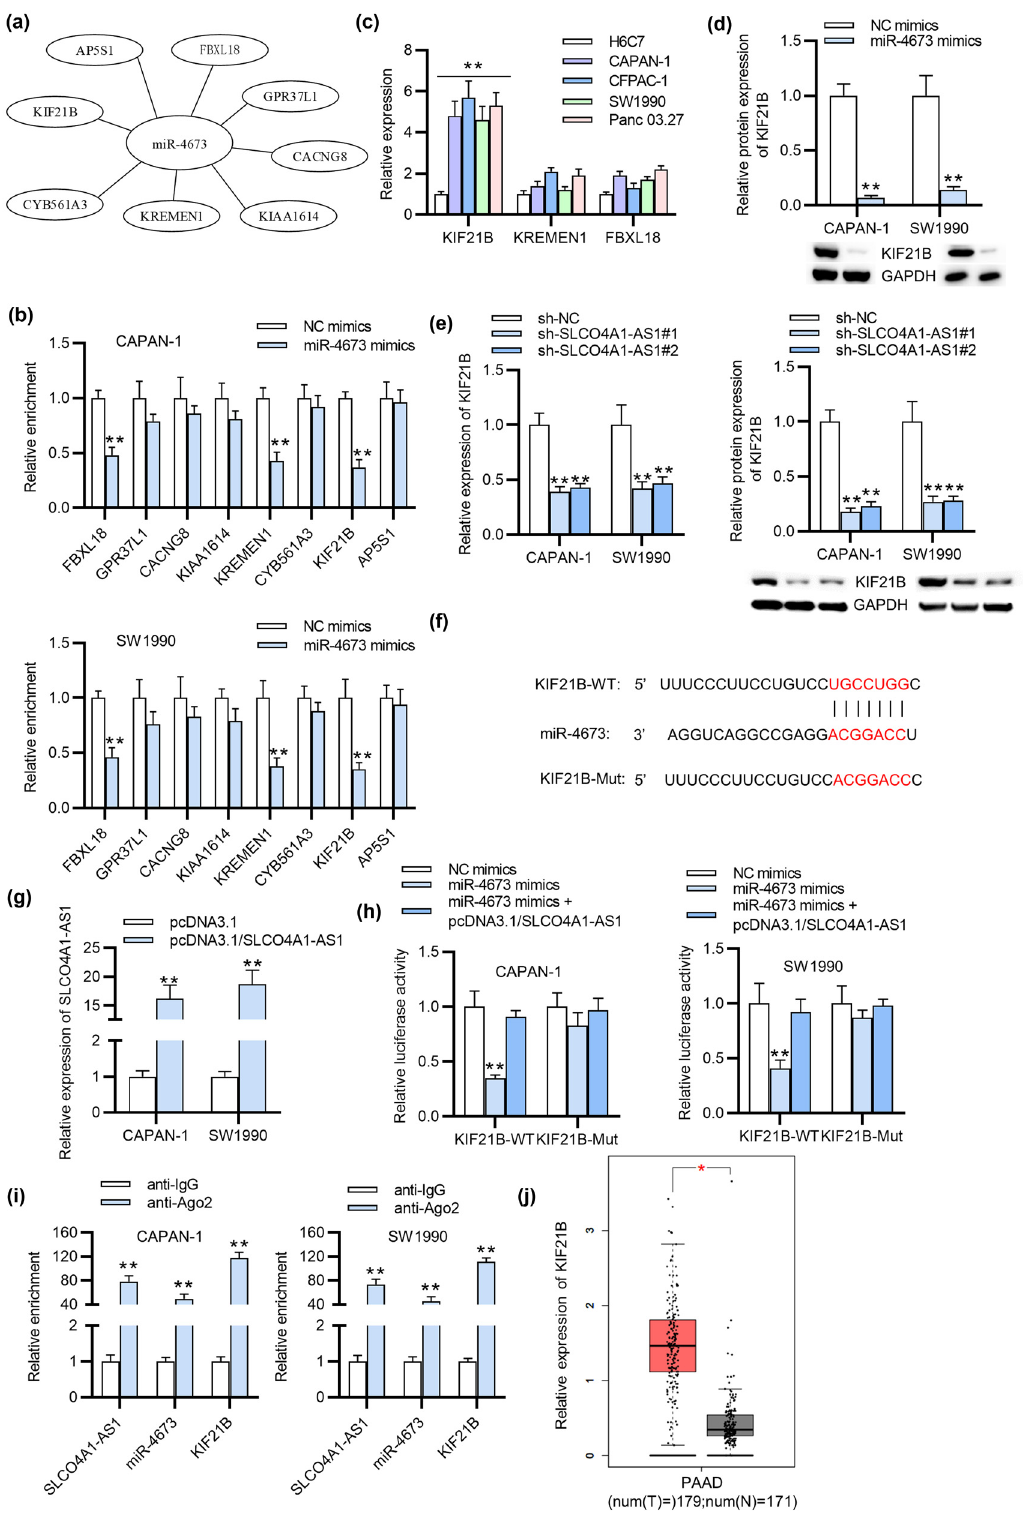
Figure 4: KIF21B is targeted by miR - 4673. ( a ) The eight candidate mRNAs of miR - 4673 were selected from TargetScan database. ( b ) qRT - PCR analyzed the expression of these miRNAs in PC cells transfected with miR - 4673 mimics. ( c ) The expression of selected mRNAs in PC cells were detected through qRT - PCR. ( d ) The protein level of KIF21B in PC cells after miR - 4673 upregulation was analyzed by qRT - PCR. ( e ) qRT - PCR assessed both the mRNA and protein levels of KIF21B in PC cells after silencing SLCO4A1 - AS1. ( f ) We searched the binding site of KIF21B on miR - 4673 from TargetScan database. ( g ) The overexpression e ffi ciency of SLCO4A1 - AS1 in PC cells was measured through qRT - PCR. ( h ) Luciferase reporter assay detected the luciferase activity of KIF21B - WT and KIF21B - MUT in PC cells transfected with miR - 4673 mimics or miR - 4673 mimics + pcDNA3.1/ SLCO4A1 - AS1. ( i ) RIP assay was applied to con fi rm the co - existence of SLCO4A1 - AS1, miR - 4673, and KIF21B in RISC. ( j ) The expression of KIF21B in PAAD and normal tissues is shown by GEPIA database. All experiments were performed in triplicate. * p < 0.05 and ** p <